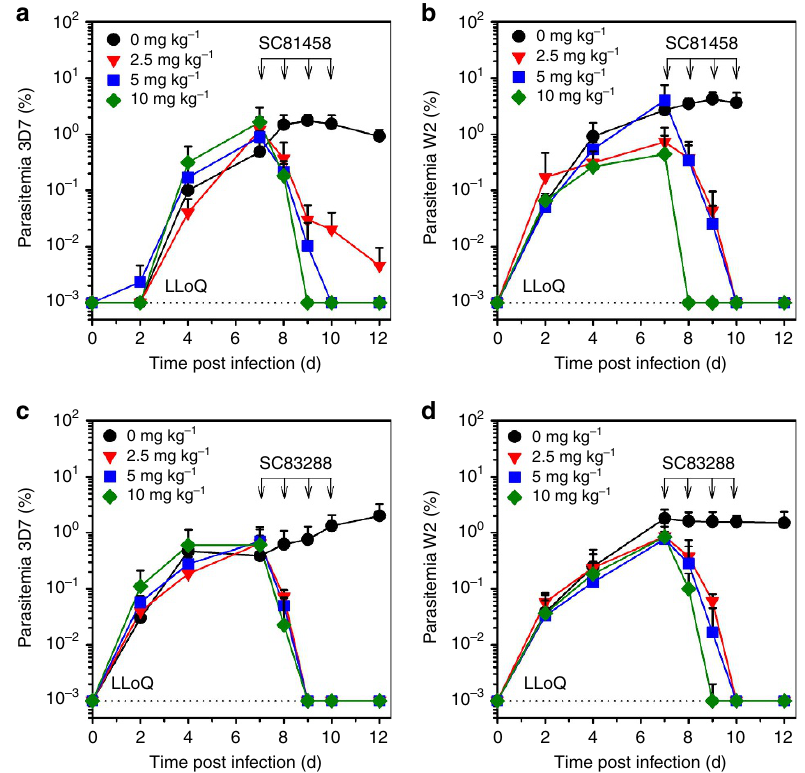
Figure 6 | In vivo efficacy of SC81458 and SC83288 in P. falciparum -infected humanized NSG mice. NSG mice engrafted with human erythrocytes were infected with the P. falciparum strains 3D7 ( a , c ) or W2 ( b , d ). The compounds SC81458 ( a , b ) or SC83288 ( c , d ) were administered i.p. once per day over 4 days starting on day 7 post infection. Parasitemia was assessed each day from day 2 post infection up to 12 days. The mean ± s.e.m. of four mice in each treatment group are